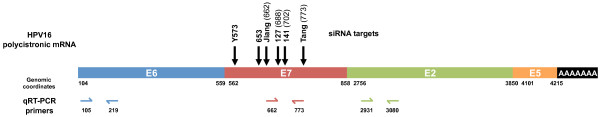
Location of siRNA and PCR primer binding sites. A representative HPV16 polycistronic transcript, showing the binding sites of the siRNAs and PCR primers used in the present study. Full details of the range of HPV16 polycistronic transcripts are provided elsewhere [3].